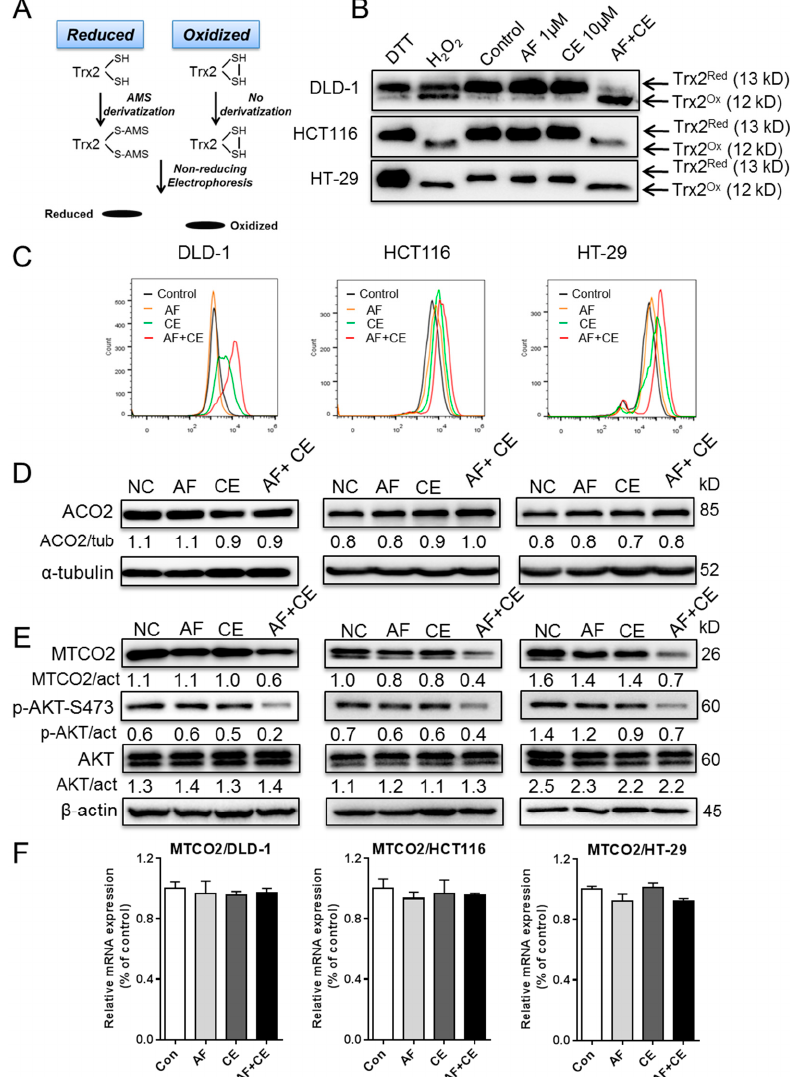
Figure 5. AF/CE combination disturbed redox homeostasis which resulted in disordered electron transport chain. ( A ) Principle of Trx2 redox Western blot assays. DLD-1, HCT116, and HT-29 cells were treated with indicated conditions for 12 h. Treatment with 5 mM H 2 O 2 for 30 min was used as a positive control (PC). ( B ) Trx2 redox state was evaluated by redox immunoblot. ( C ) Three cell lines were treated with the indicated conditions for 12 h, and cellular ROS levels were measured by flow cytometry analysis after the cells were stained with DCF-DA. ( D , E ) DLD-1, HCT116 and HT-29 cells were treated with indicated conditions for 24 h, and cell extracts were analyzed by Western blot for ACO2, MTCO2, p-Akt (ser473) and total Akt protein. ( F ) MTCO2 mRNA level in three cell lines treated with the indicated conditions.